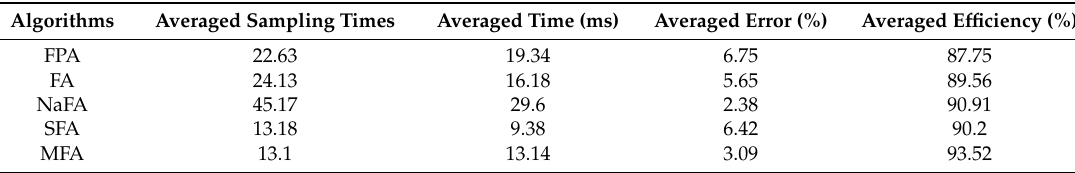
Table 11. Simulation results comparison of the five algorithms at 45 ◦ C.